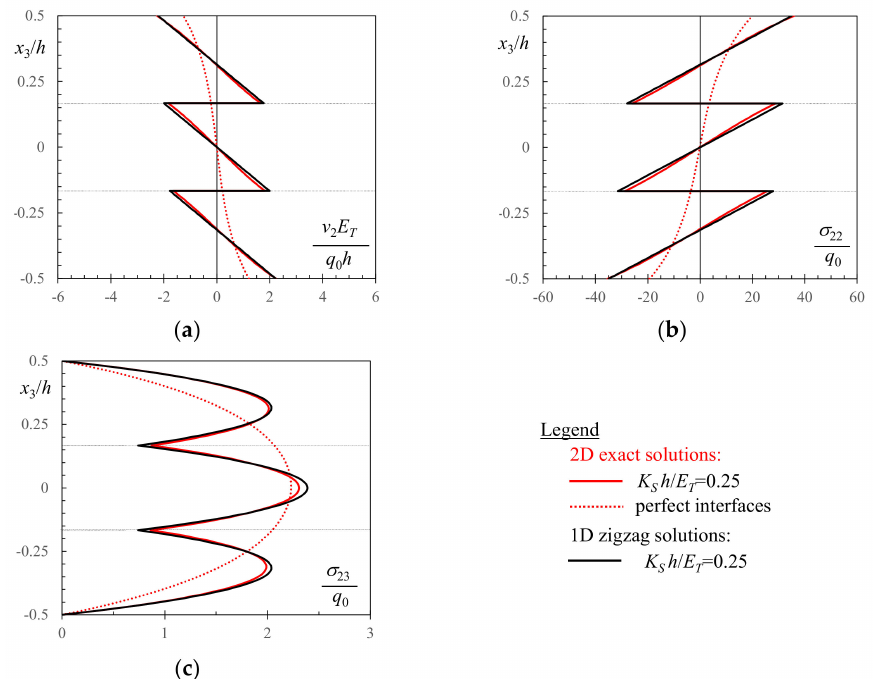
Figure 6. 2D exact and 1D zigzag solutions for simply supported three-layer beam (0 ◦ /0 ◦ /0 ◦ ) with L / h = 5 having interfaces of equal stiffness and subjected to sinusoidal transverse load: ( a ) local longitudinal displacements (at x 2 = 0); ( b ) bending stresses (at x 2 = 0.5 L ); ( c ) transverse shear stresses (at x 2 = 0) determined from local equilibrium. The red dotted lines correspond to the 2D exact solution for perfectly bonded interfaces.